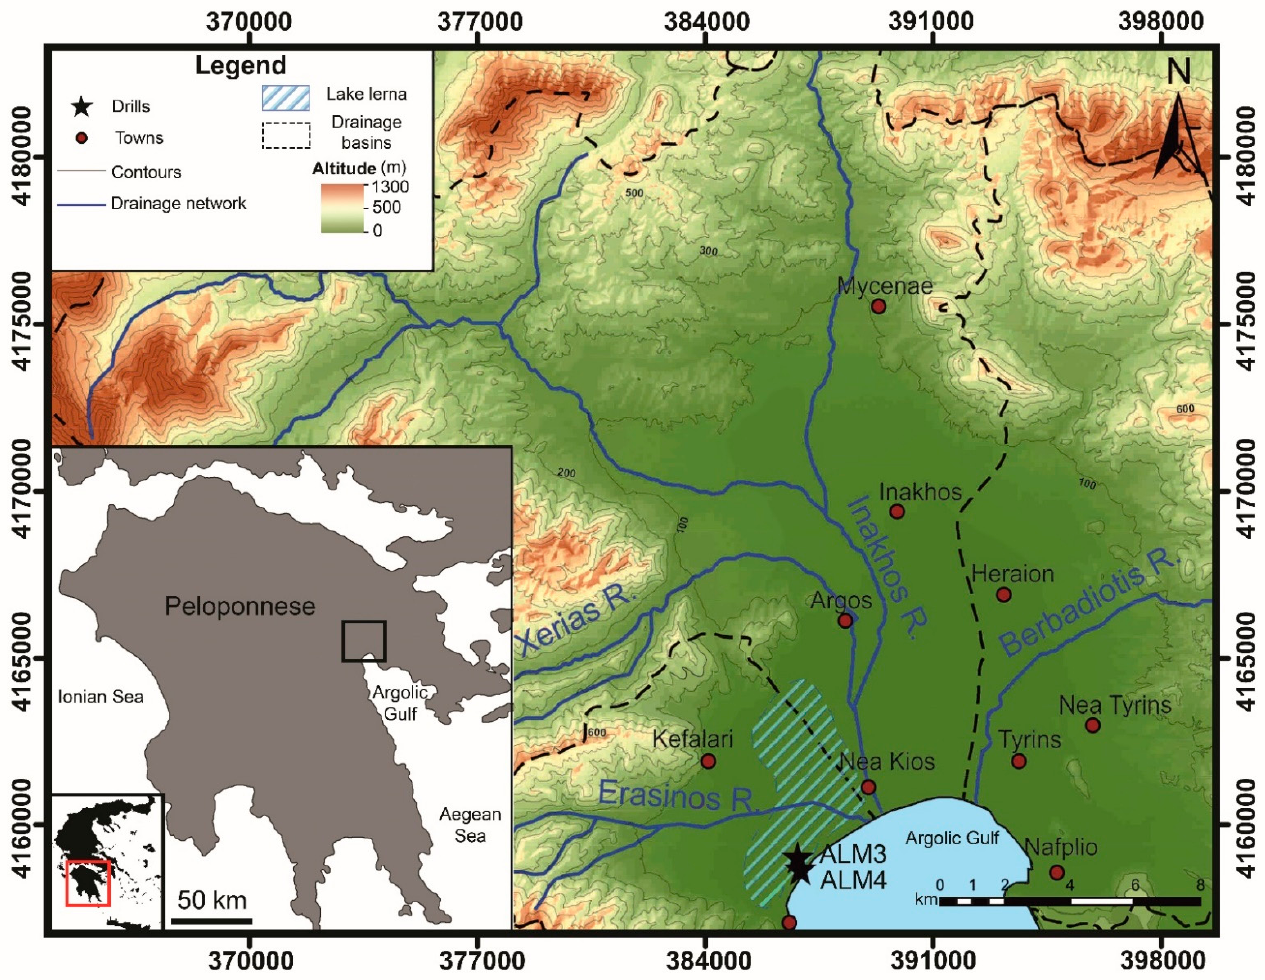
Figure 1. The study area, along with the main morphological structures and the sampling localities in the Argos Plain, Peloponnese, Greece. Made with the geographical coordinate system: Greek Grid, EGSA 87.